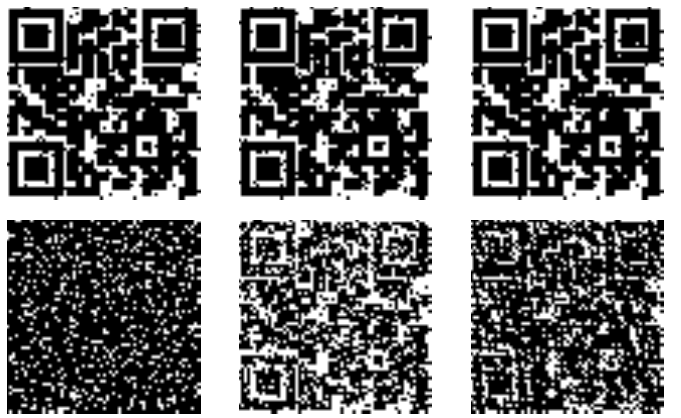
Figure 10. Extracted watermarks under Gaussian attacks. The first row corresponds to KS1Ms, KS2Ms, and KS3Ms while the second row corresponds to KMs, FrCMs, and FrCMMs.